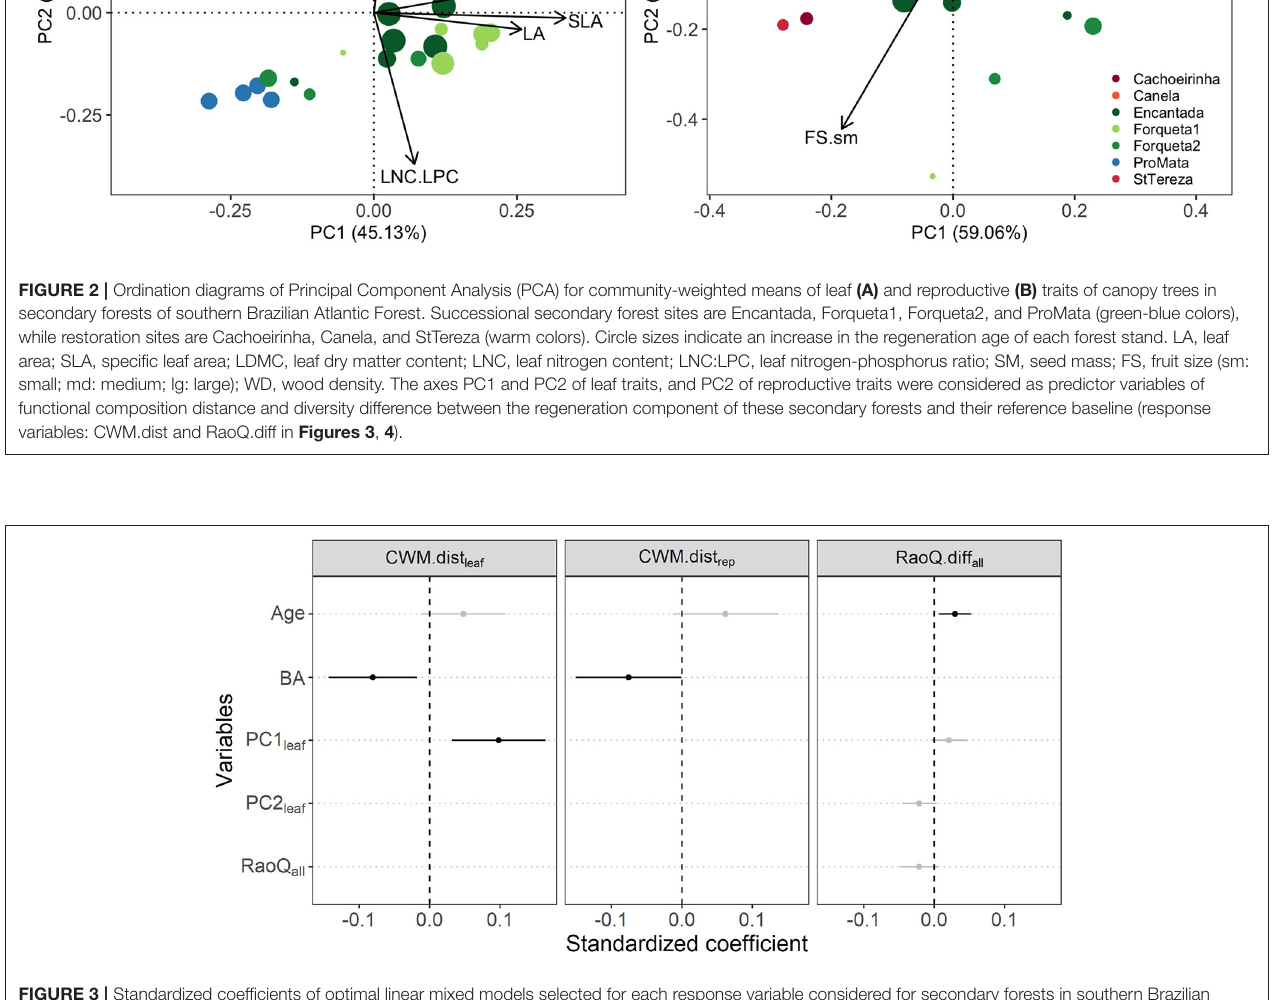
FIGURE 3 | Standardized coefficients of optimal linear mixed models selected for each response variable considered for secondary forests in southern Brazilian Atlantic Forest. Response variables are functional traits composition distance (CWM.dist in terms of leaf or reproductive traits) and diversity difference (RaoQ.diff) between the regeneration component of secondary forest stands and their reference baseline. Selected predictor variables are the age of forest stand since regeneration started (Age) and parameters derived from the canopy of studied secondary forests: total basal area of canopy trees (BA), distinct spectra of strategies (PC1 leaf and PC2 leaf shown in Figure 2A , with a clear acquisitive strategy gradient in PC1), and the functional diversity based on all traits (RaoQ.all). Points are the average estimates of the models and bars correspond to 95% confident intervals (CI). Variables that do not overlap zero (indicated in black) have significant effects on the response